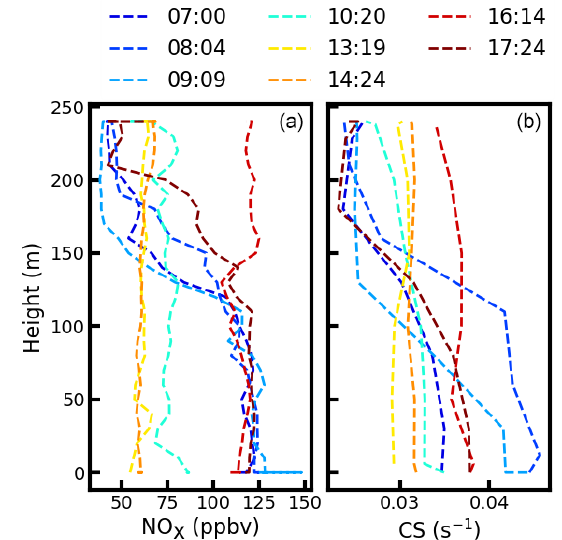
Figure 4. The measured (a) NO x and (b) CS at different altitudes. The filled colors of different lines denote the different measurement